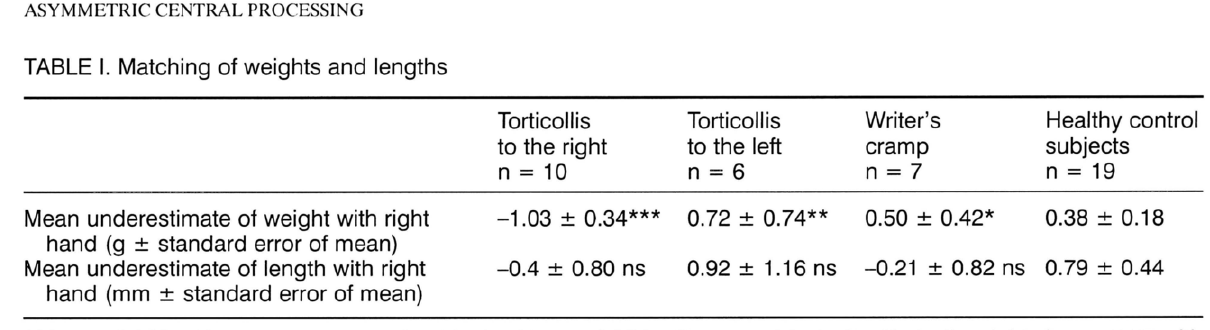
FIG. 1. Underestimate of lengths of right/dominant hand.